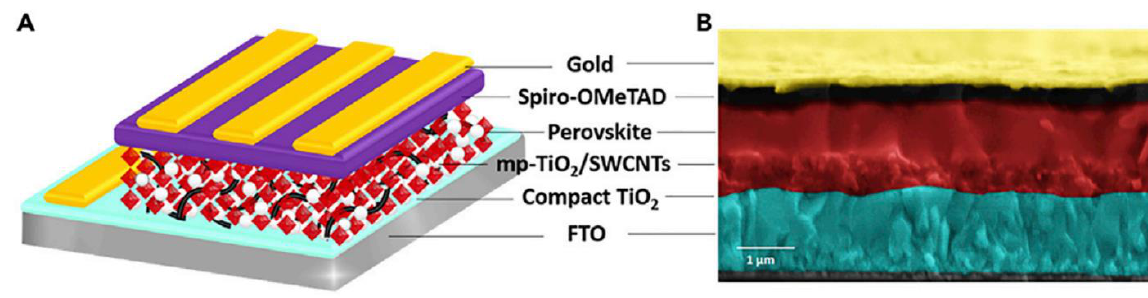
Figure 21. ( A ) Schematic diagram of the structure of PSCs, where CNTs (black lines) were incorpo- rated into the TiO 2 mesoporous scaffold layer. ( B ) Cross-sectional SEM image of the complete device [171]. Copyright 2019, with permission from Elsevier.